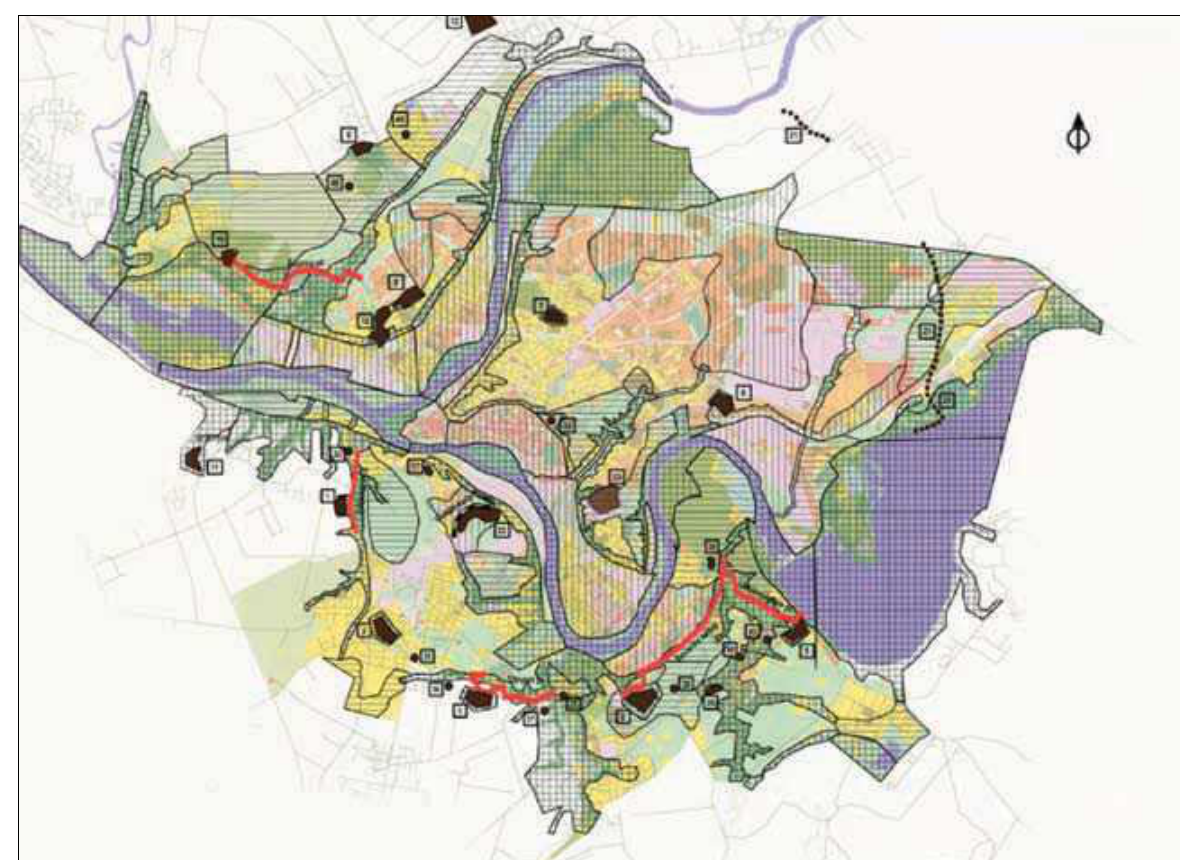
Fig. 3. natural frame of kaunas city and fortifications of kaunas